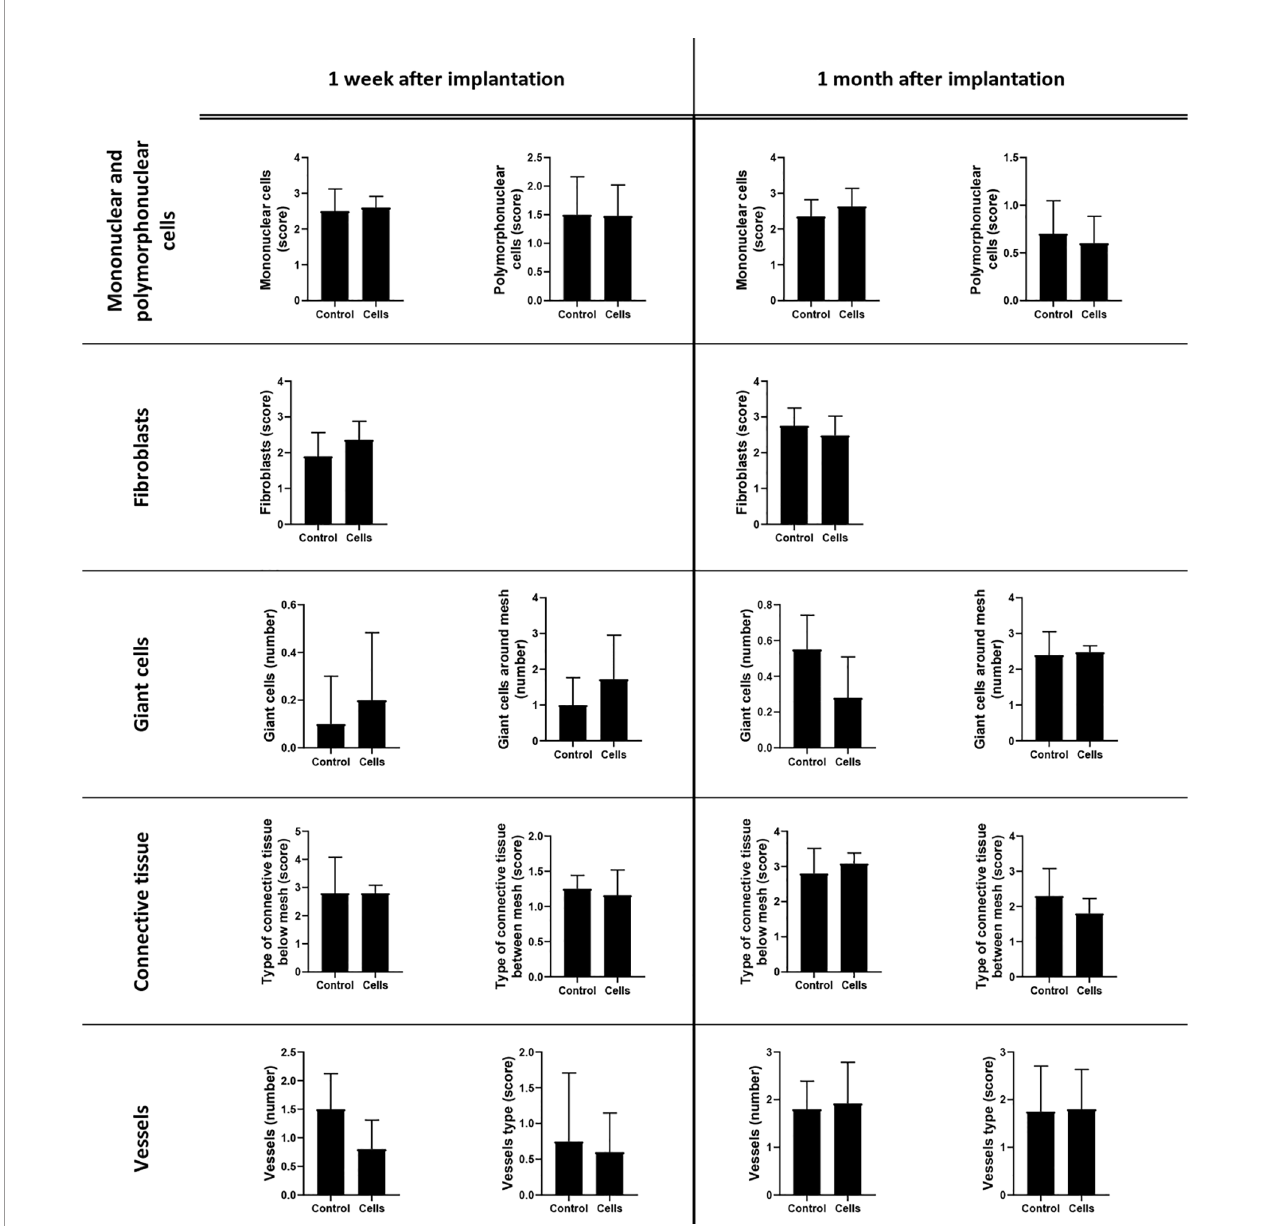
FIGURE 7 | Histological evaluation of surgical meshes and surrounding tissues 1 week and 1 month after mesh implantation. The microscopic appearance of the tissue surrounding the surgical mesh was examined in the hematoxylin – eosin (HE) and Masson ’ s trichome-stained specimens. Polymorphonuclear leukocytes (score), mononuclear cells (score), vessels (type and number), giant cells (number), and fi broblasts (score) between the mesh area were evaluated in fi ve oil immersion fi elds. The type and organization of the connective tissue presented between and below the mesh were also scored. The average number of giant cells (number around the mesh fi bers) was evaluated under a high-power fi eld (×40 objective fi eld). The scoring criteria are shown in Table 2 . All the data are presented as mean ± standard deviation. The graphs were created with GraphPad Prism